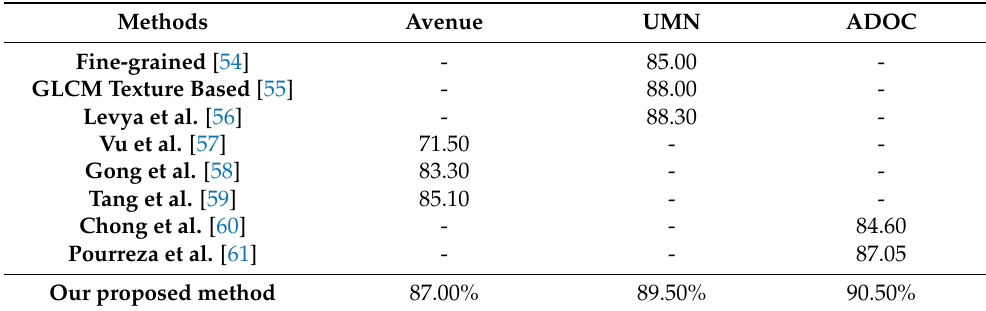
Table 7. Comparison of proposed method accuracy with state-of-the-art methods over Avenue, UMN, and ADOC datasets.